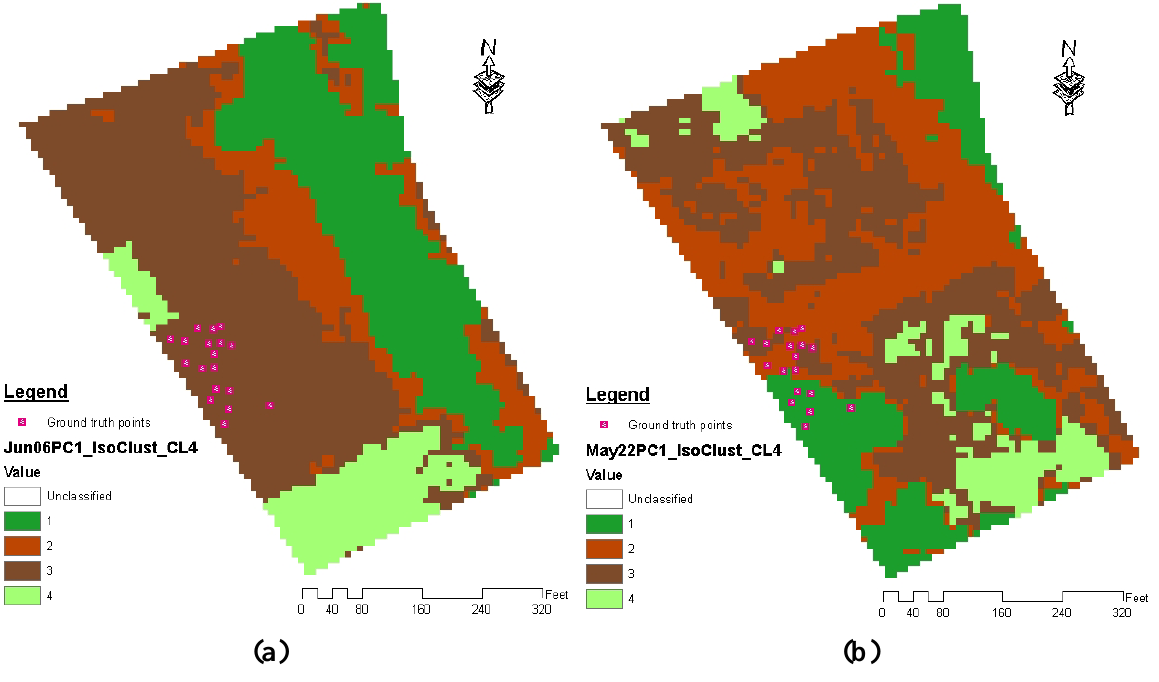
Figure 3. Ground truth points of blueberry plants in unsupervised classified image of study area (blueberry plants) shown on May 22, 2006 (a) and June 06, 2006 (b) with ISODATA clustered classified QuickBird